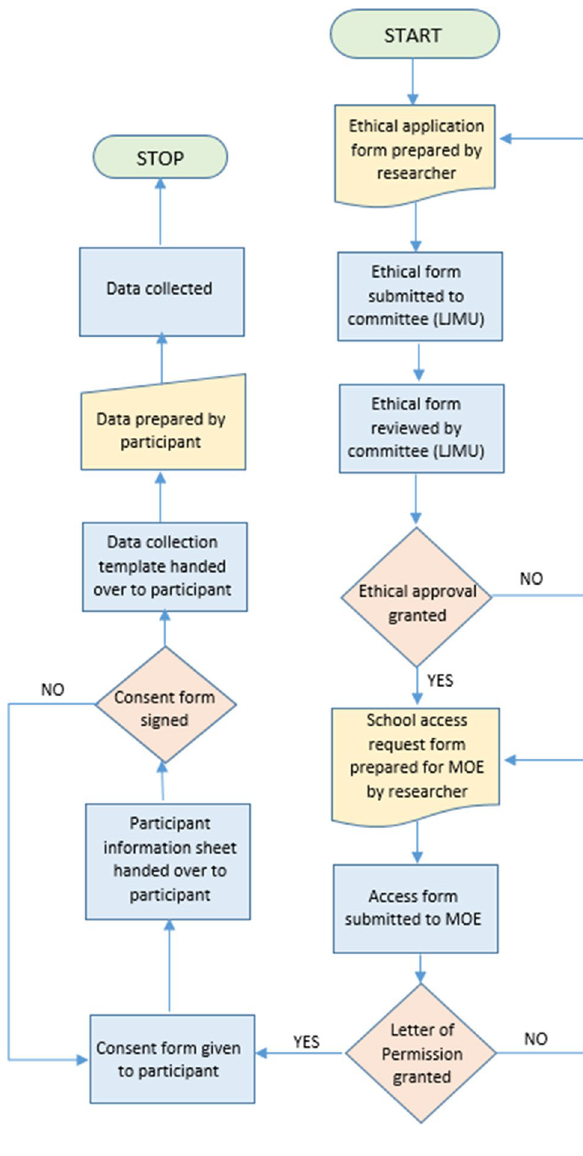
Fig. 4 Data collection process